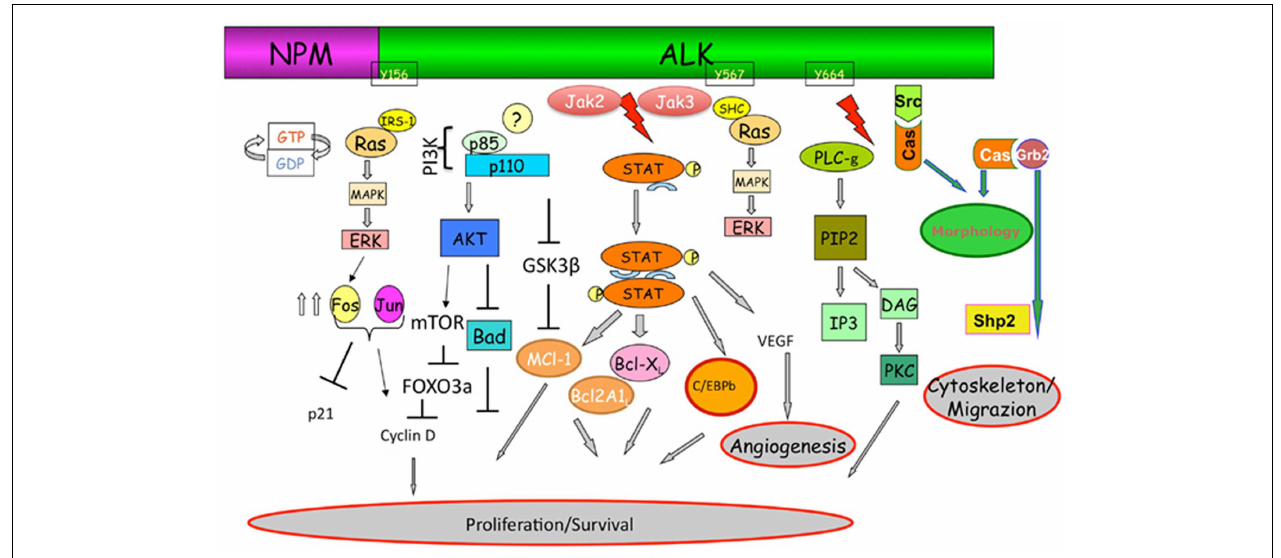
FIGURE 1 |TheALK signaling pathway with its cross-talk with other pathways involved in the resistance toALK-inhibitors . Adapted from Tabbo et al. (47).